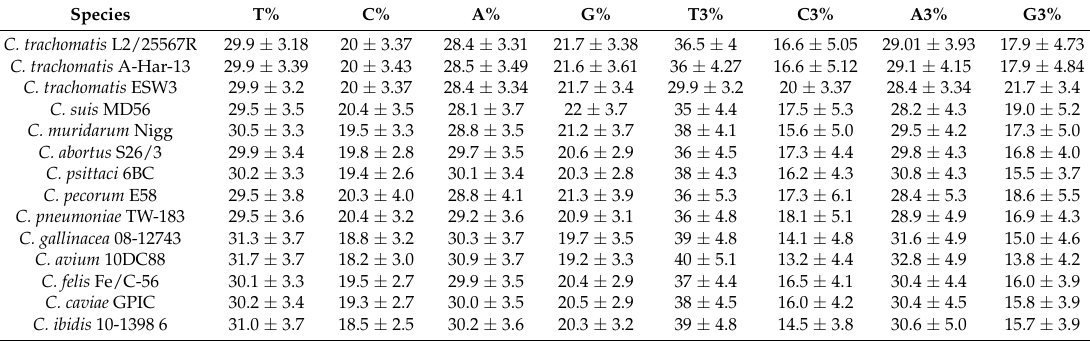
Table 1. Nucleotide content (%) of the 14 Chlamydia strains at gene levels.